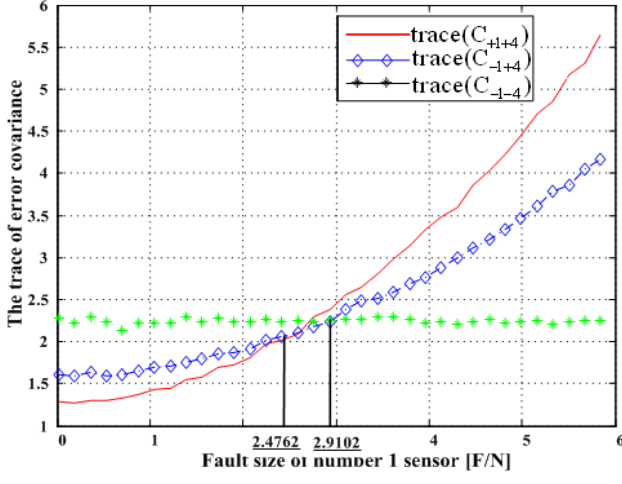
), trace(C )and trace(C ) with respect to fault magnitude in Figure 20. +1+4 -1+4 -1-4